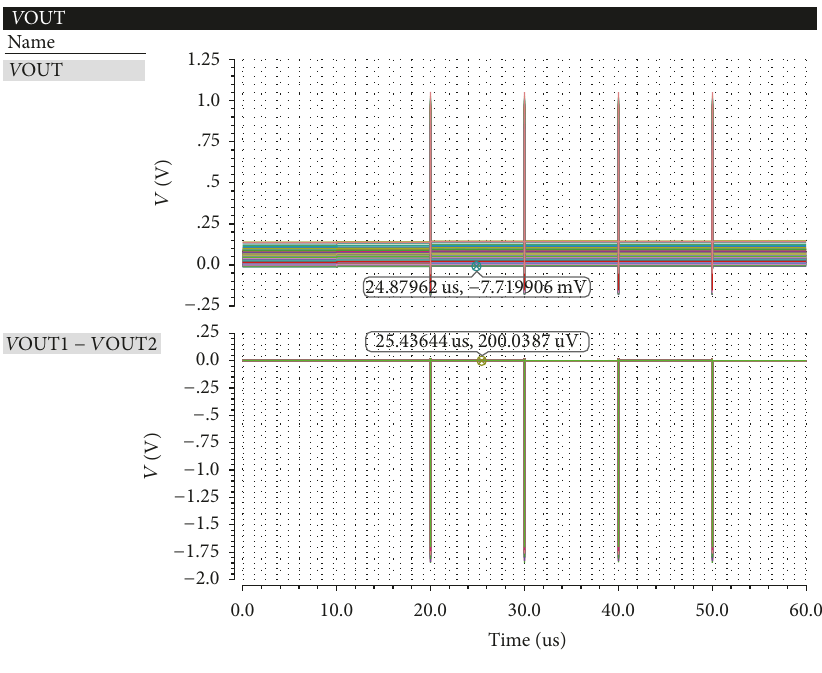
Figure 6: Simulation results of offset voltage suppression.